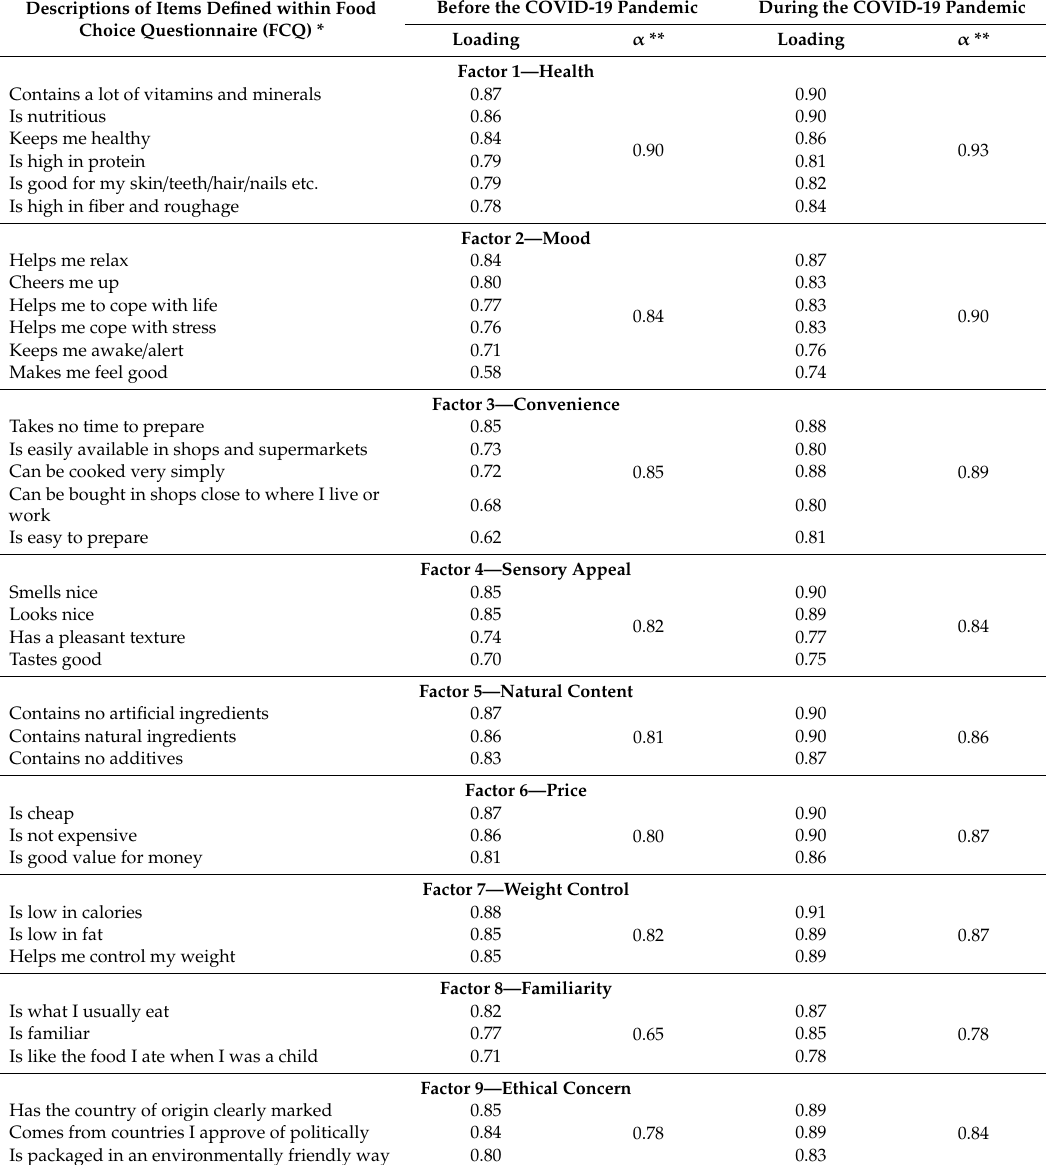
Table 2. The results of the loading and Cronbach’s alpha coe ffi cient for the applied Food Choice Questionnaire (FCQ) for the period before and during the Coronavirus Disease 2019 (COVID-19) pandemic for the sample of adolescents studied within the PLACE-19 Study ( n =